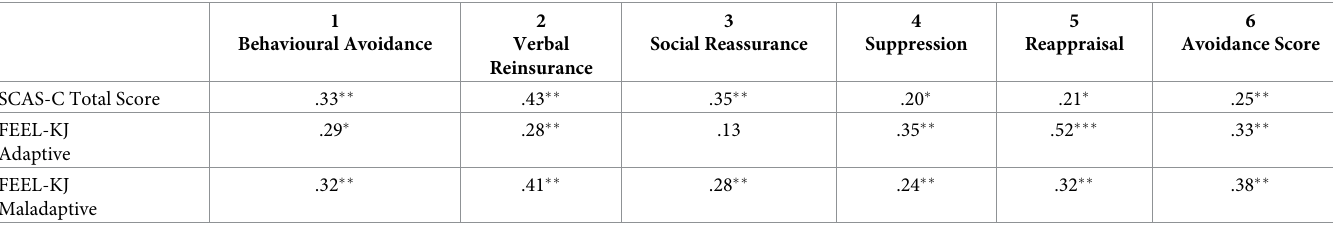
Table 5. Correlations of the BAER-C subscales and the avoidance score with the anxiety scale of the SCAS-C and the adaptive and maladaptive scales of the FEEL-KJ.